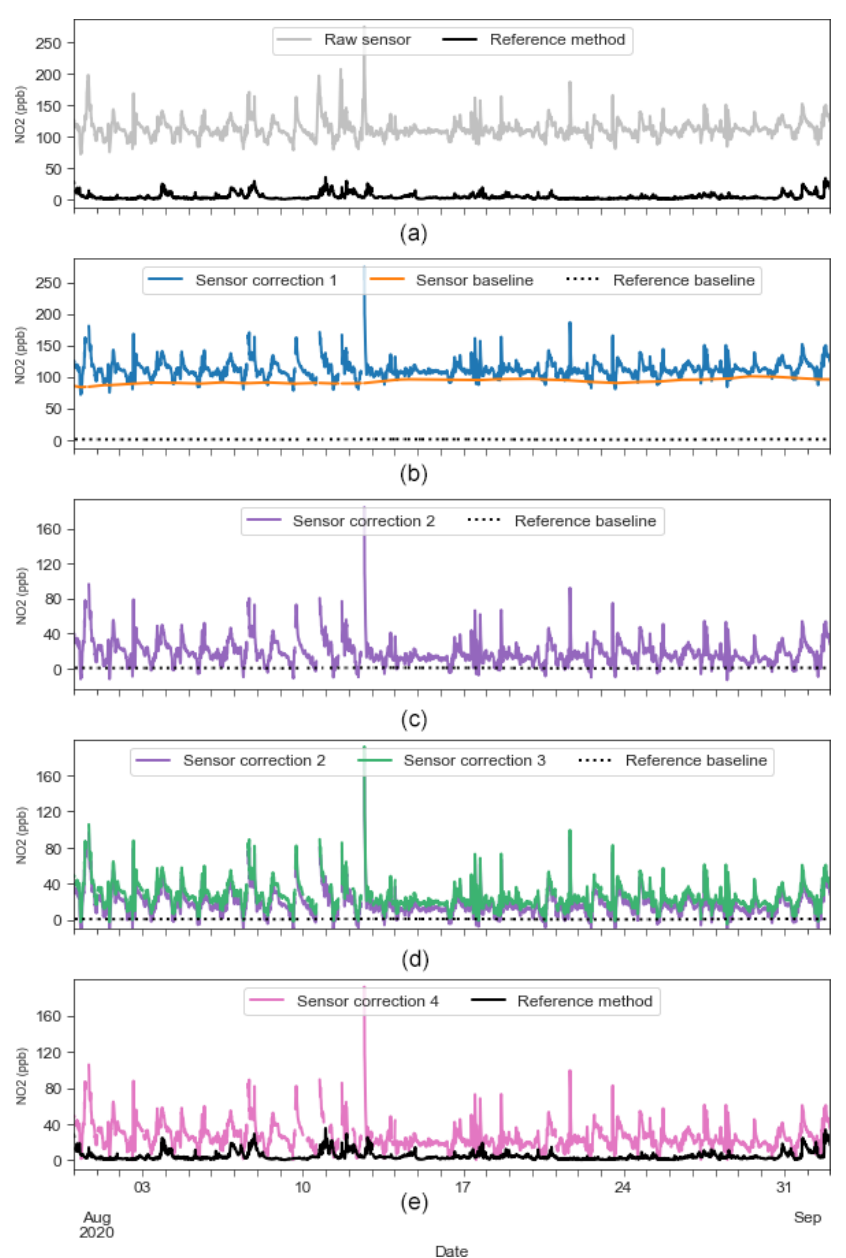
Figure 5. Illustrative impacts of each stage in the sensor baseline offset correction model upon 15min mean sensor observations at St Ebbe’s for August 2020. (a) Raw sensor signal and reference method. (b) Correction 1 – application of empirical filters for anomaly and outlier removal. (c) Correction 2 – baseline offset correction. (d) Correction 3 – compensation for efficacy of baseline offset correction. (e)